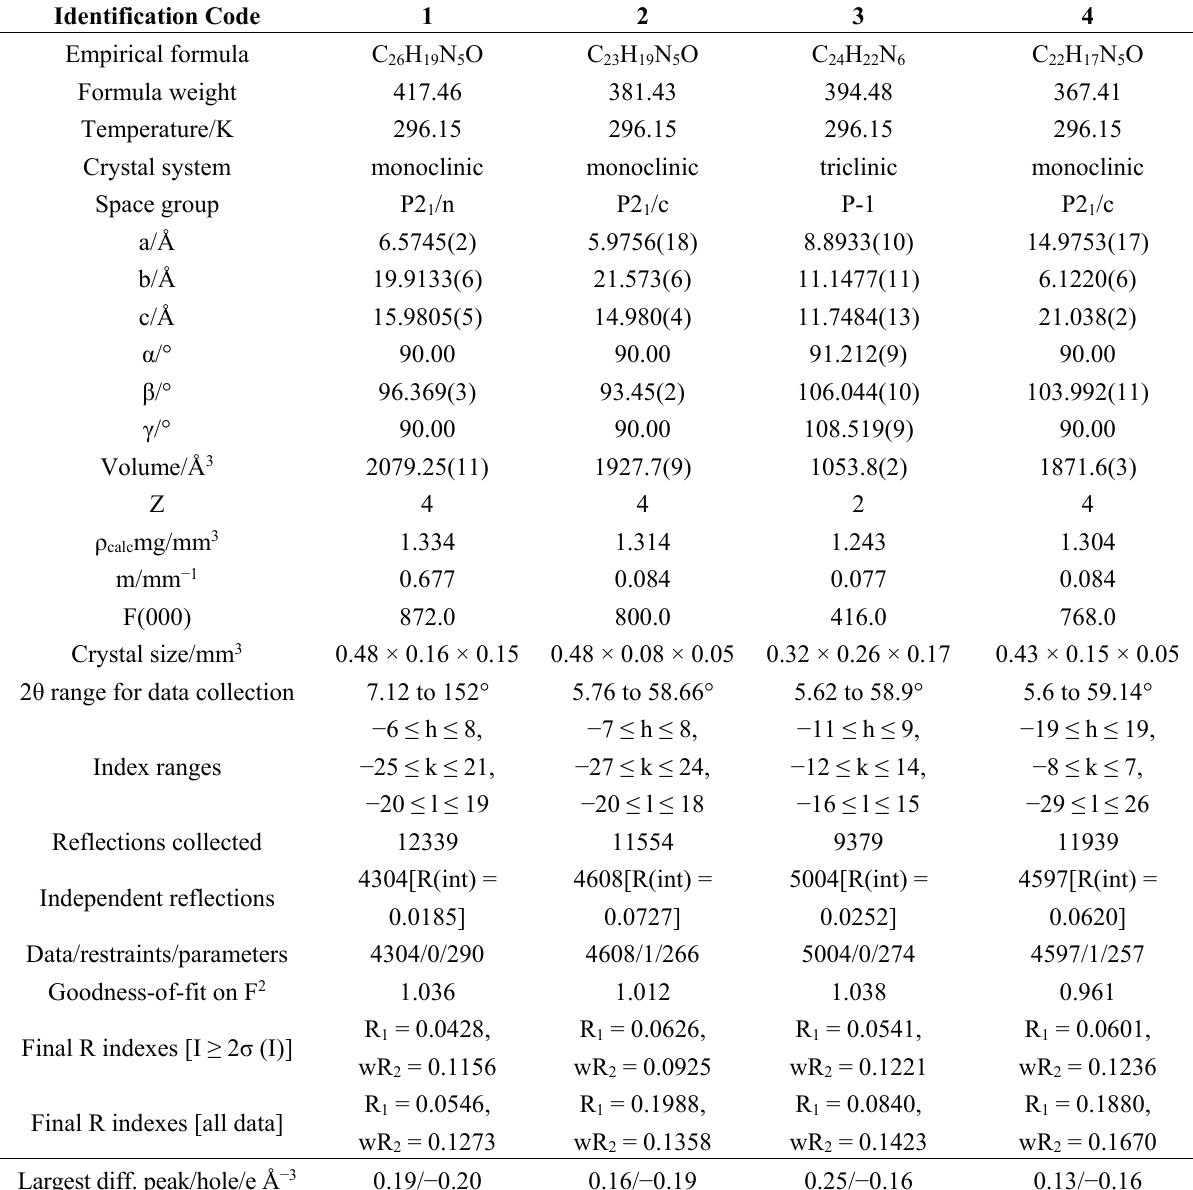
Table 1. Crystal data and structure refinement